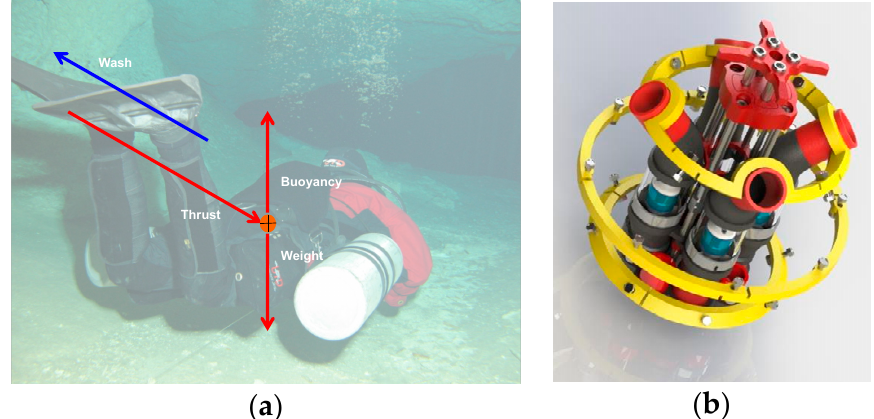
during translation.